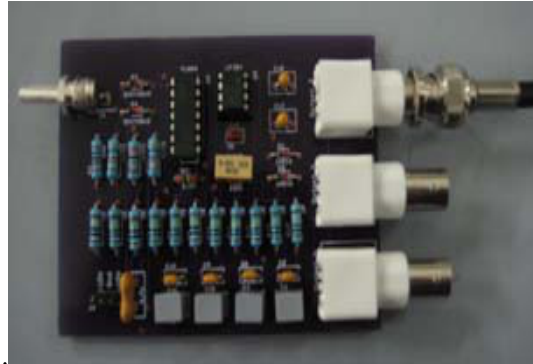
Figure 4. Electrodynamics sensor fabricated in printed circuit